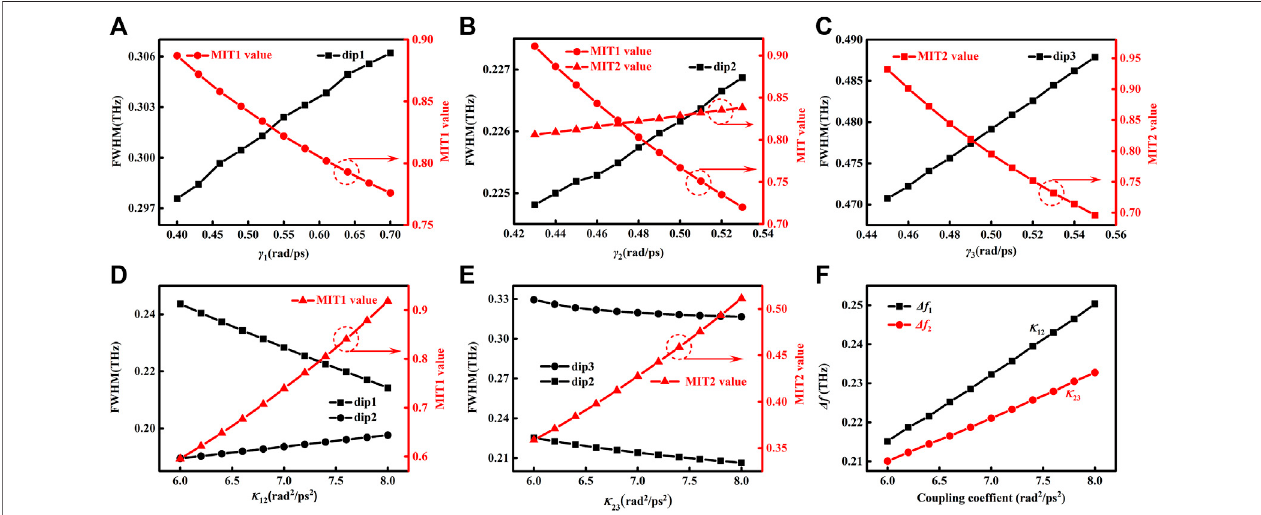
FIGURE 7 | (A) In fl uence of γ 1 on the FWHM of dip1 and the value of the MIT1 window. (B) In fl uence of γ 2 on the FWHM of dip2, and the values of MIT1 and MIT2 windows. (C) In fl uence of γ 3 on the FWHM of dip3 and the value of the MIT2 window. (D) In fl uence of κ 12 on the value of the MIT1 window, and the FWHM of dip1 and dip2. (E) In fl uence of κ 23 on the value of the MIT2 window, and the FWHM of dip1 and dip2. (F) Dependency between Δ f 1 and κ 12 . Dependency between Δ f 2 and κ 23